Question: Does the plotted quantity increase or decrease?
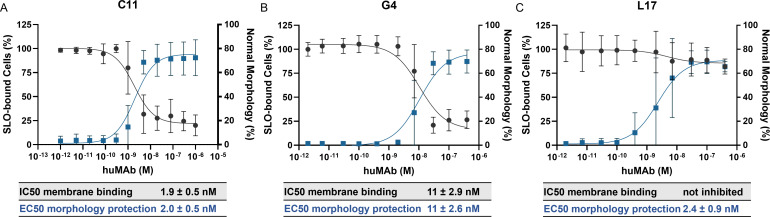
Answer: increasing